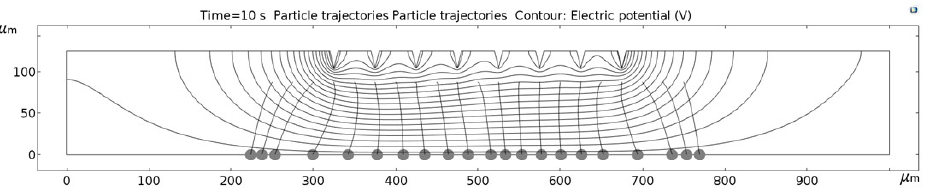
Figure 15. Computed particle trajectories and electric potential for the Pin electrode geometry.